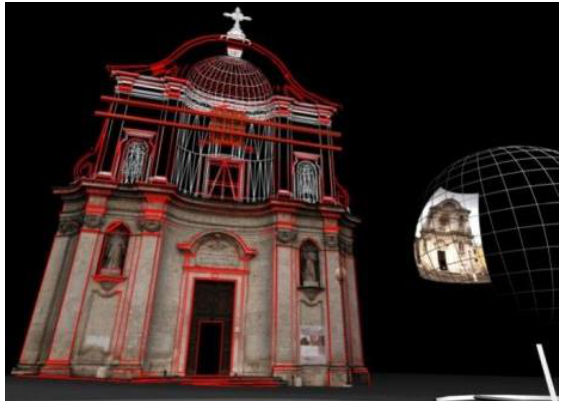
Figure 1. 3D model (low-poly) with photorealistic texture from oriented spherical